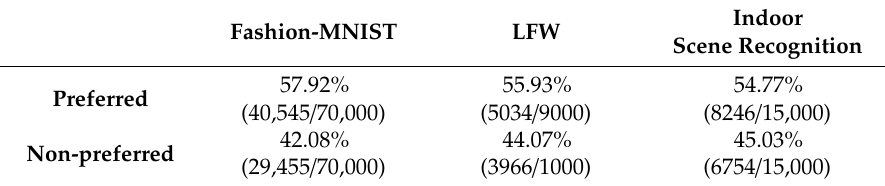
Table 1. Data classification ratios of user preferences in each dataset.